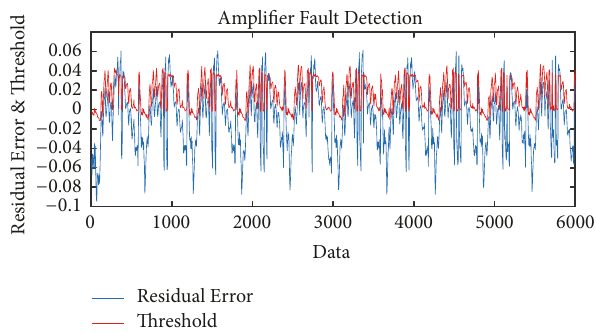
Figure 7: Detection result for amplifier